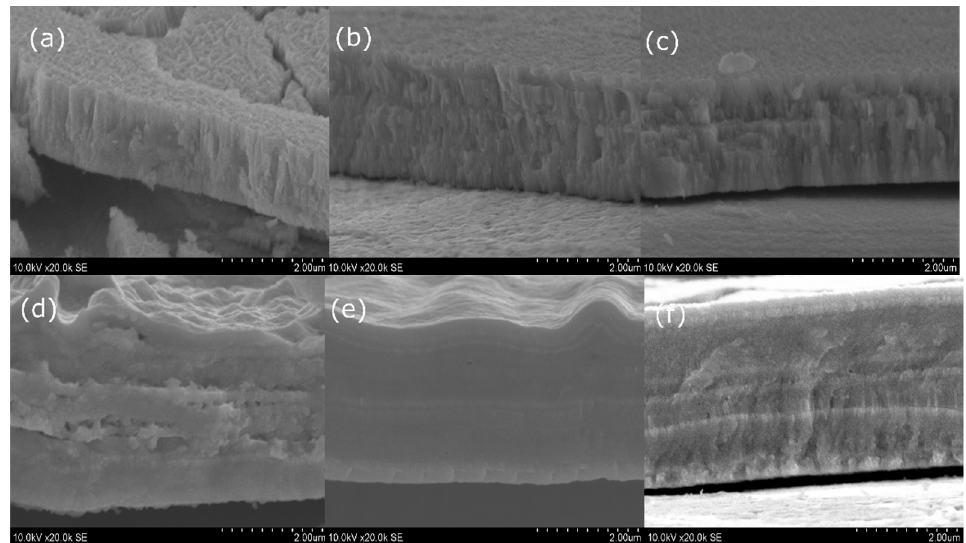
Figure 2. SEM cross-sectional images of the thin films: BCO ( a ), BCY10 ( b ), BCY20 ( c ), BZO ( d ), BZY20 ( e ), and BZCY ( f ).